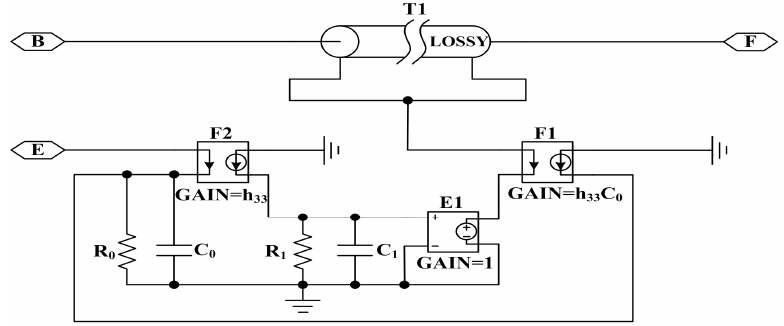
Figure 6. PSpice circuit of the Leach’s model of a piezoelectric ceramic ring vibrating in thickness direction.